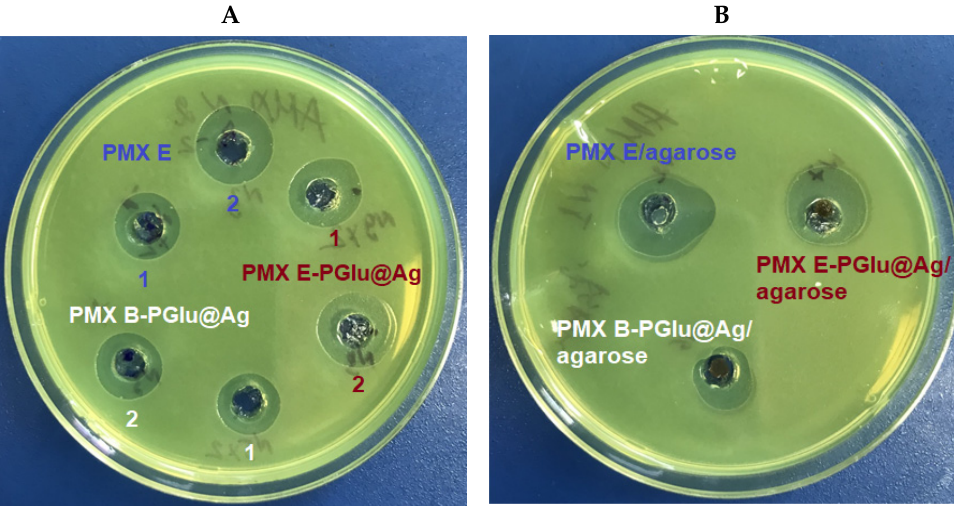
Figure 13. Suppression of Pseudomonas aeruginosa growth by exposure to different PMX formulations for 24 h: ( A ) dispersions of PMX hybrid delivery systems and free PMX as control: contents of the PMX in zones 1 and 2 were 37 ± 1 and 74 ± 2 µg/zone; ( B ) composite hydrogels and PMX in hydrogel as control (85.6 ± 1.7 µg of PMX per each zone).